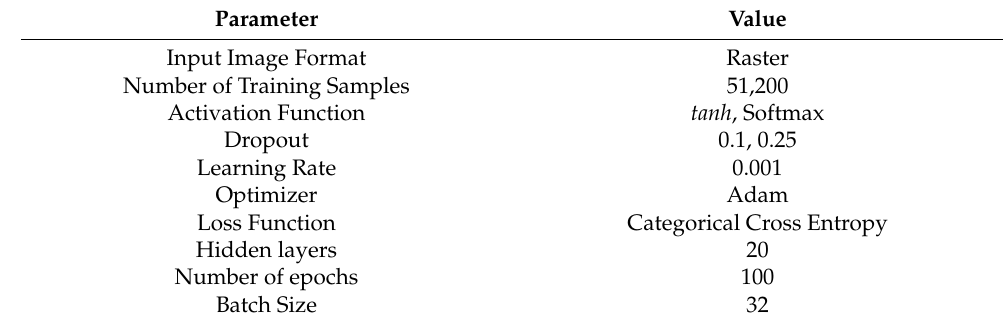
Table 5. Hyperparameters for the Bi-LSTM model.